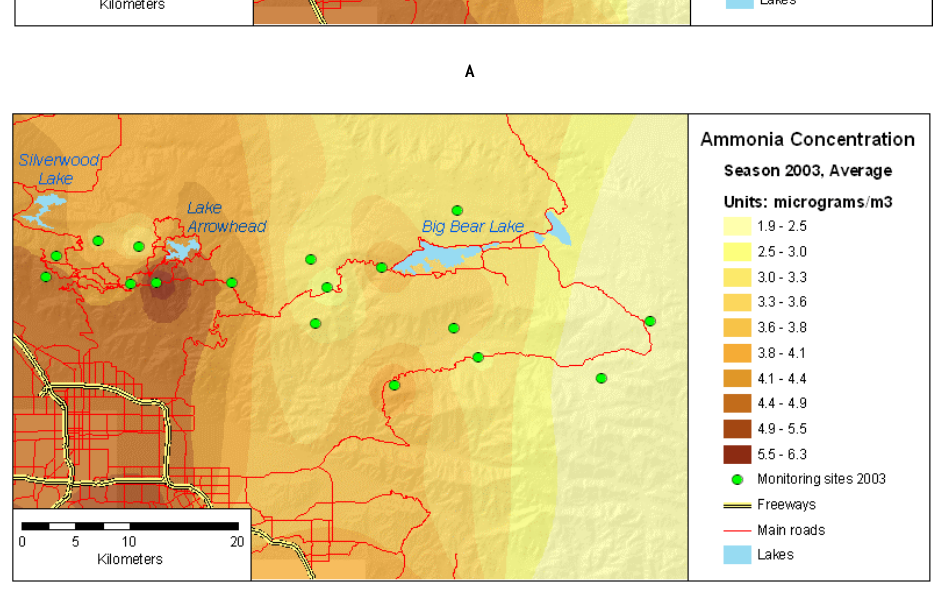
means ranged 3 , such values ranged 3 concentrations may 3